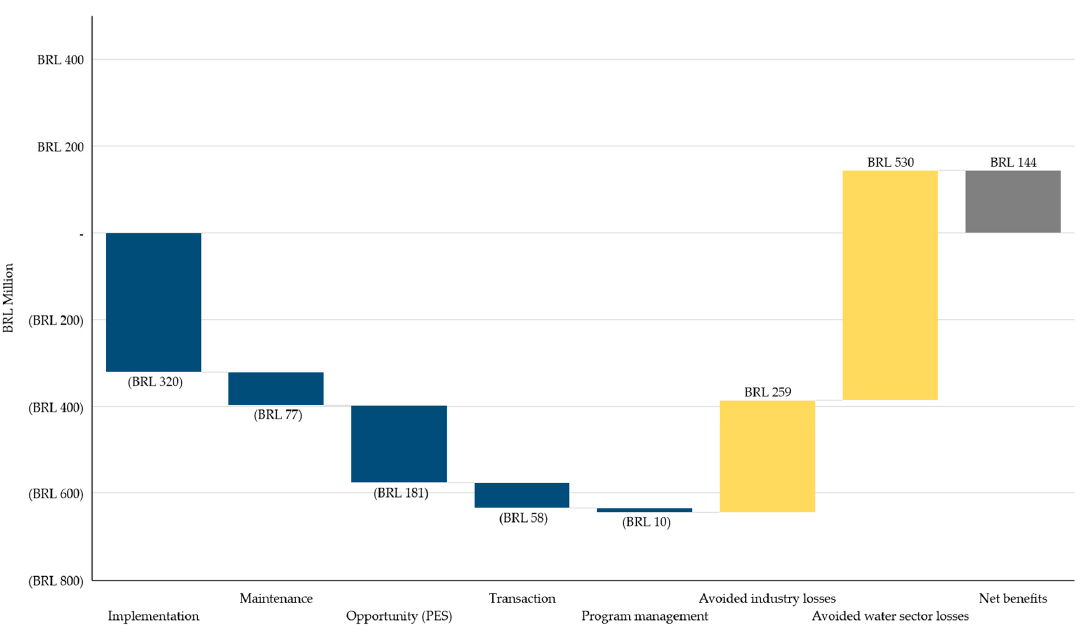
Figure 7. Full lifecycle (35-year) NPV if only the water supply to the industrial and water sectors is counted as benefits (Scenario 1). Colors indicate costs (blue bars), benefits (yellow bars), and net benefits (grey bar).